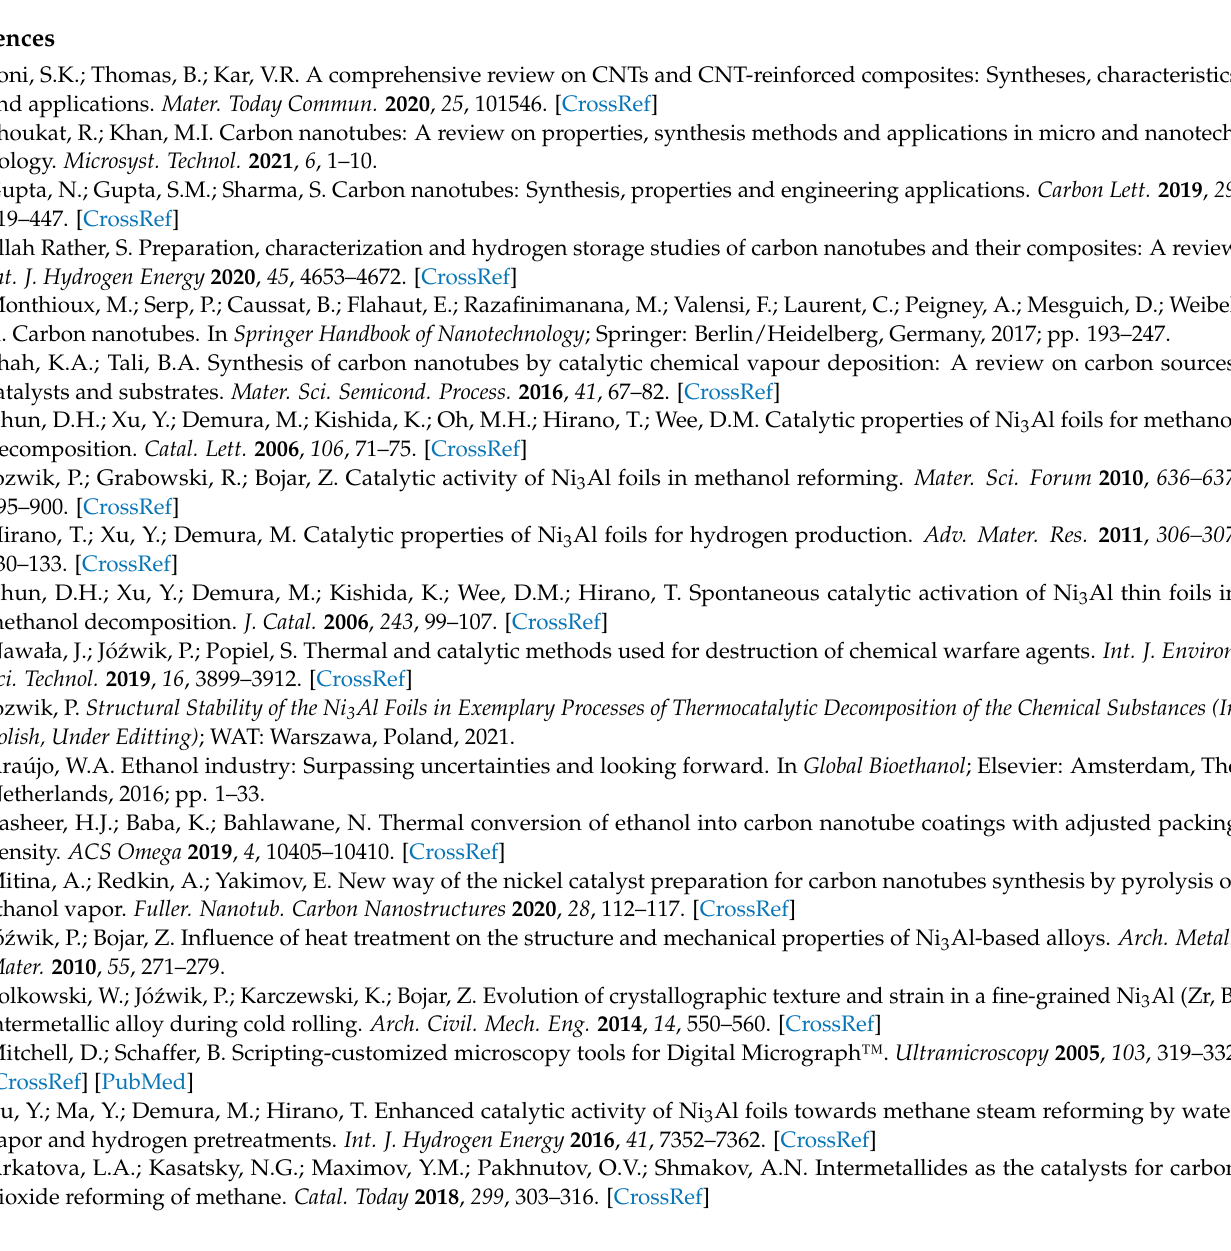
(d) The presence of Ni nanoparticles involved in the ethanol decomposition process and the formation of carbon nanostructures were observed in the CNT/CNF structure irrespective of the steam content and decomposition